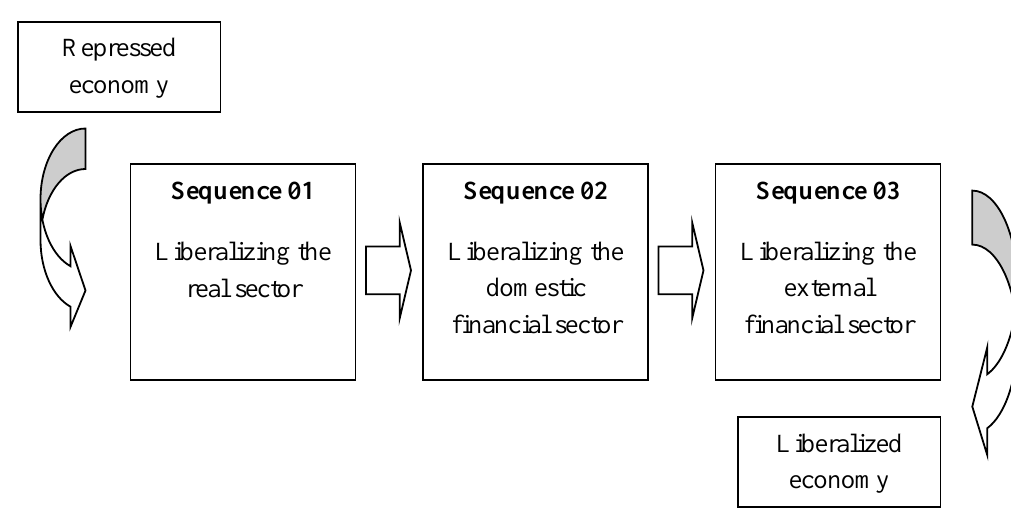
Figure 1: Conceptual Framework - Optimal Sequence of